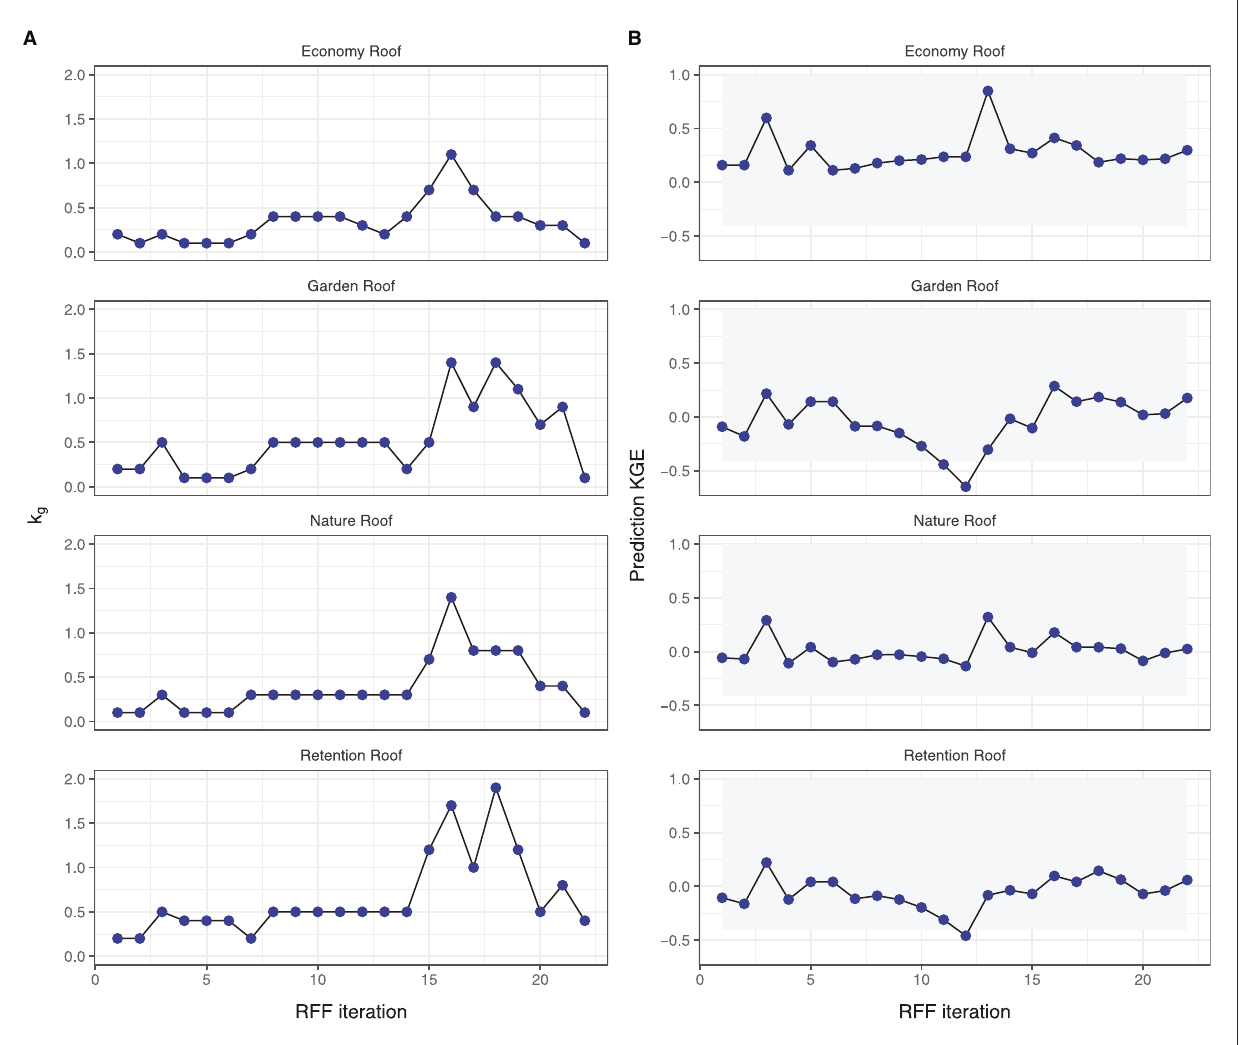
FIGURE2 Development of (A) optimized green roof factors k g and (B) corresponding Kling-Gupta Efficiency (KGE) criteria for each iteration of the Rolling Forward Forecast (RFF) for the four green roof types using experimental input data. Gray shaded areas represent KGE values > -0.41, i.e., where the GR2L predicted values on the test data set perform better than a mean-value